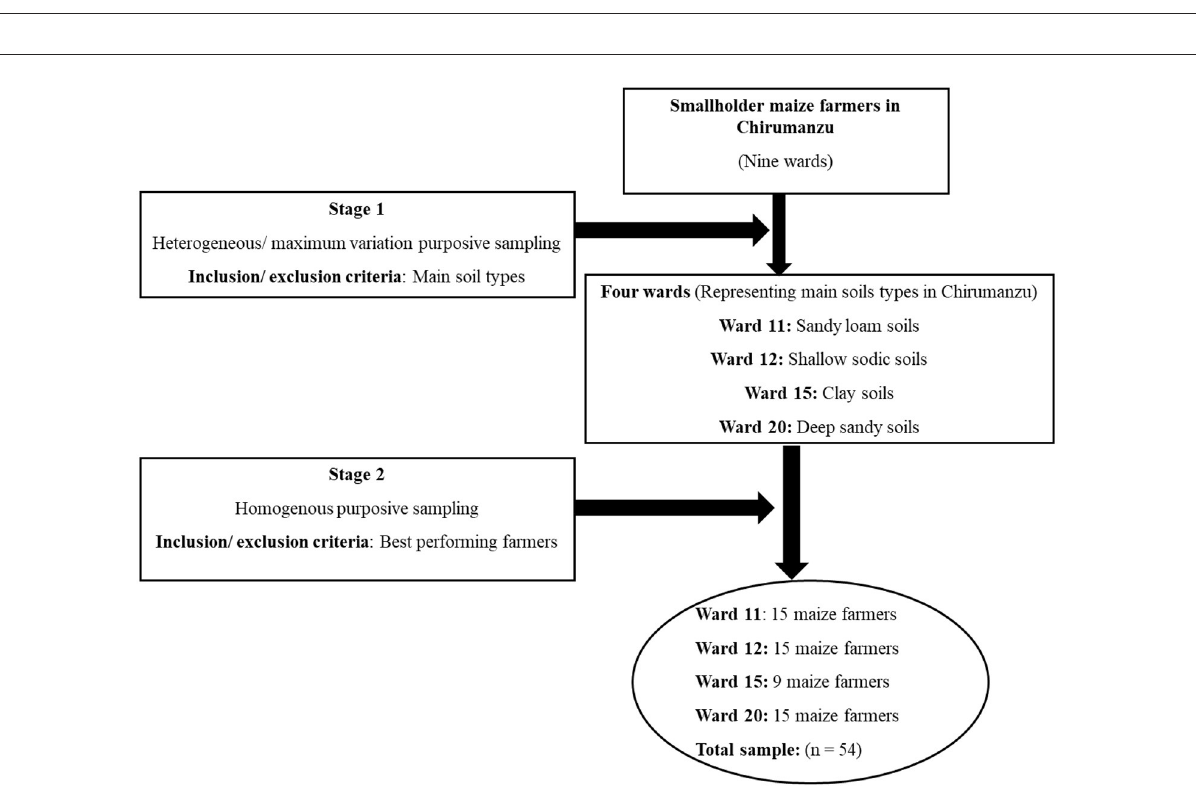
FIGURE3 Sampling procedure. Source: Author’s